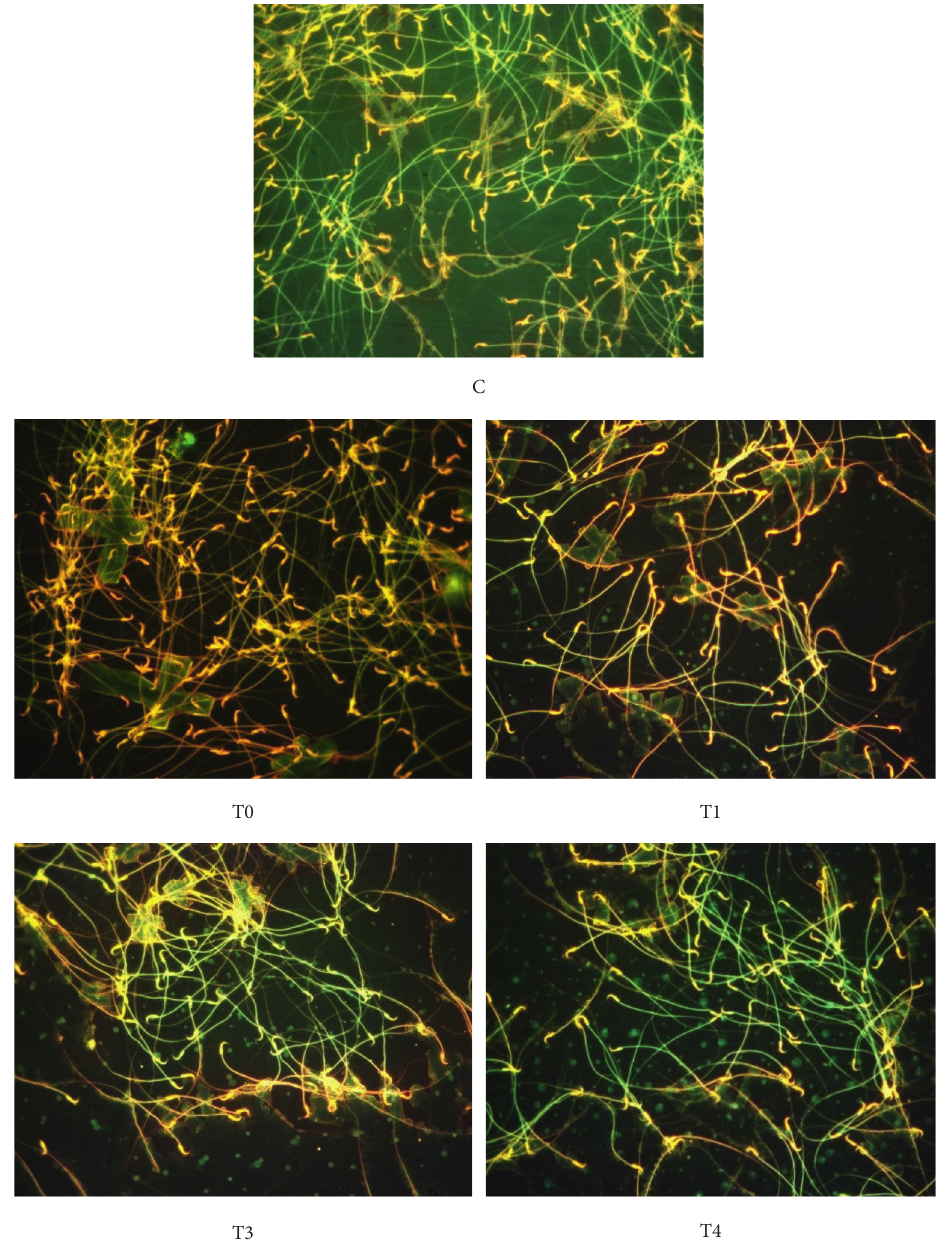
Figure 2: Apoptotic and necrotic spermatozoa of rats exposed to TCDD and treated with α -tocopherol. Rats in the control group (C) were administered 0.5mL of corn oil twice daily at 4h intervals for 45d. Rats in groups T0, T1, T2, and T3 were administered TCDD 700ng/kg BW daily and 4h later were administered corn oil, 77, 140, and 259mg/kg BW daily α -tocopherol, respectively, for 45d. The membrane of apoptotic spermatozoa will be green with yellowish cytoplasm and nucleus, and necrotic spermatozoa will be brown. Meanwhile, live spermatozoa were green (acridine orange staining), at 100 × magnification under a fluorescence microscope (Nikon Eclipse E800, Tokyo,